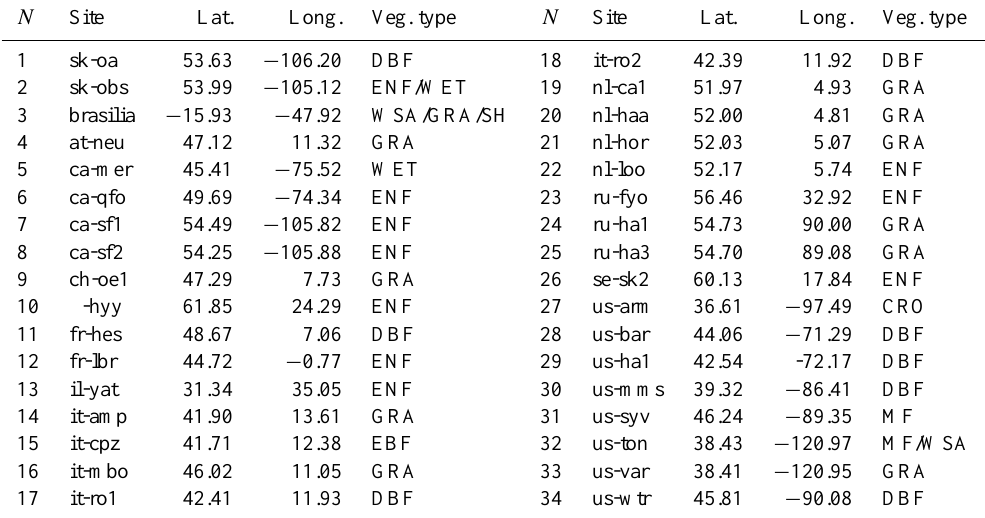
Table 1. List of flux tower sites used for the verification. The listed biome types are deciduous broadleaf forest (DBF), evergreen broadleaf forest (EBF), deciduous needle-leaf forest (DNF), evergreen needle-leaf forest (ENF), mixed forest (MF), woody savannahs (WSA), grass- lands (GRA), crops (CRO), and wetlands (WET). N Site Lat. Long. Veg. type Lat.